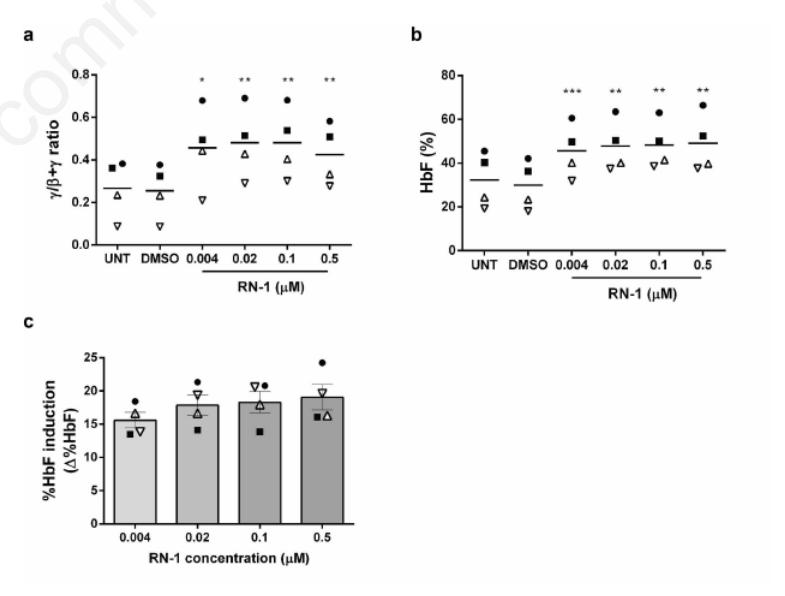
Figure 2. RN-1 increases -globin mRNA and fetal hemoglobin (HbF) expression in ery- 0 -thalassemia/hemoglobin E (HbE) patients throid cells derived from four individual γ with divergent HbF baseline levels. (a) Globin mRNA expression ( / + ratio) measured β by quantitative real-time PCR in cells day 14 of culture. (b) Percentage of HbF in total γ β γ hemoglobin determined by HPLC. (c) % HbF induction ( %HbF) was calculated by subtracting the RN-1 treated samples from vehicle control (DMSO). *P<0.05; **P<0.01; Δ ***P<0.001. UNT (untreated control); DMSO (vehicle